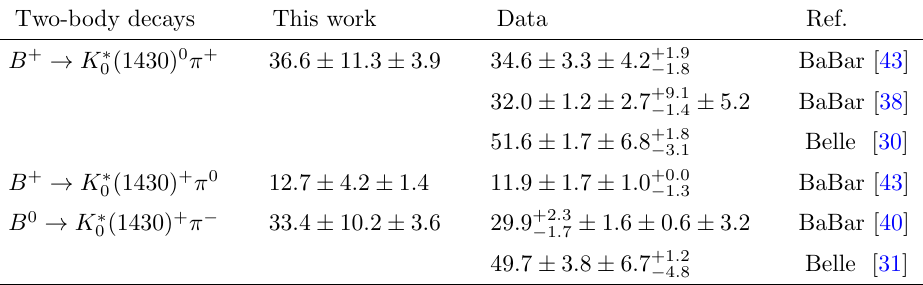
Table 4 . Comparison of the extracted predictions with the experimental measurements for the relevant two-body branching fractions (in units of 10 (cid:0) 6 ). The (cid:12)rst error for the theoretical results is added in quadrature from the errors in table 2, the second error comes from the uncertainty of B ( K (cid:3) (1430) ! K(cid:25) ) = 0 : 93 (cid:6) 0 : 10 0